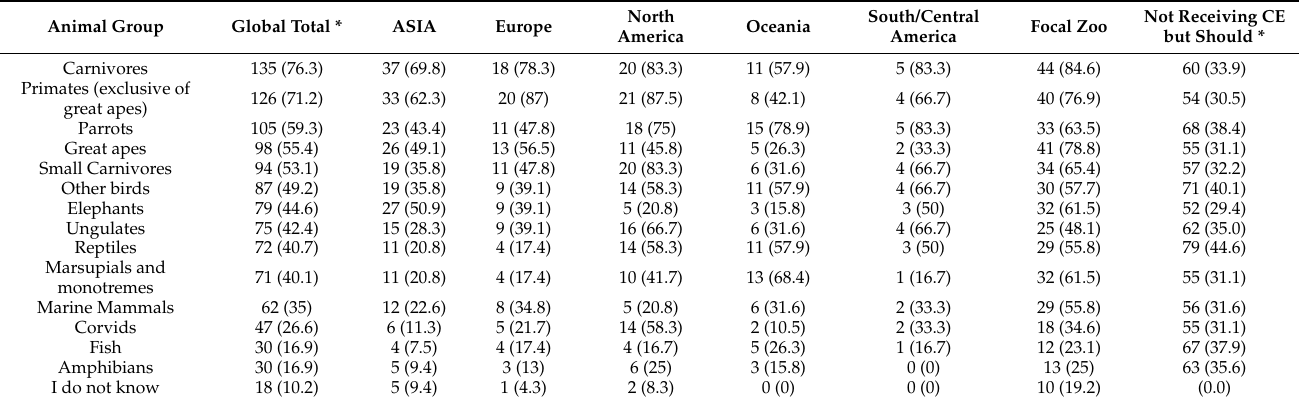
Table 4. The number of respondents, by region and globally, that reported which animal groups receive cognitive enrichment (CE) within their facility; with the final column showing the percentage of those animal groups which respondents feel should be receiving cognitive enrichment but currently do not. Animal groups organized according to global total in descending order. Percentage is presented in